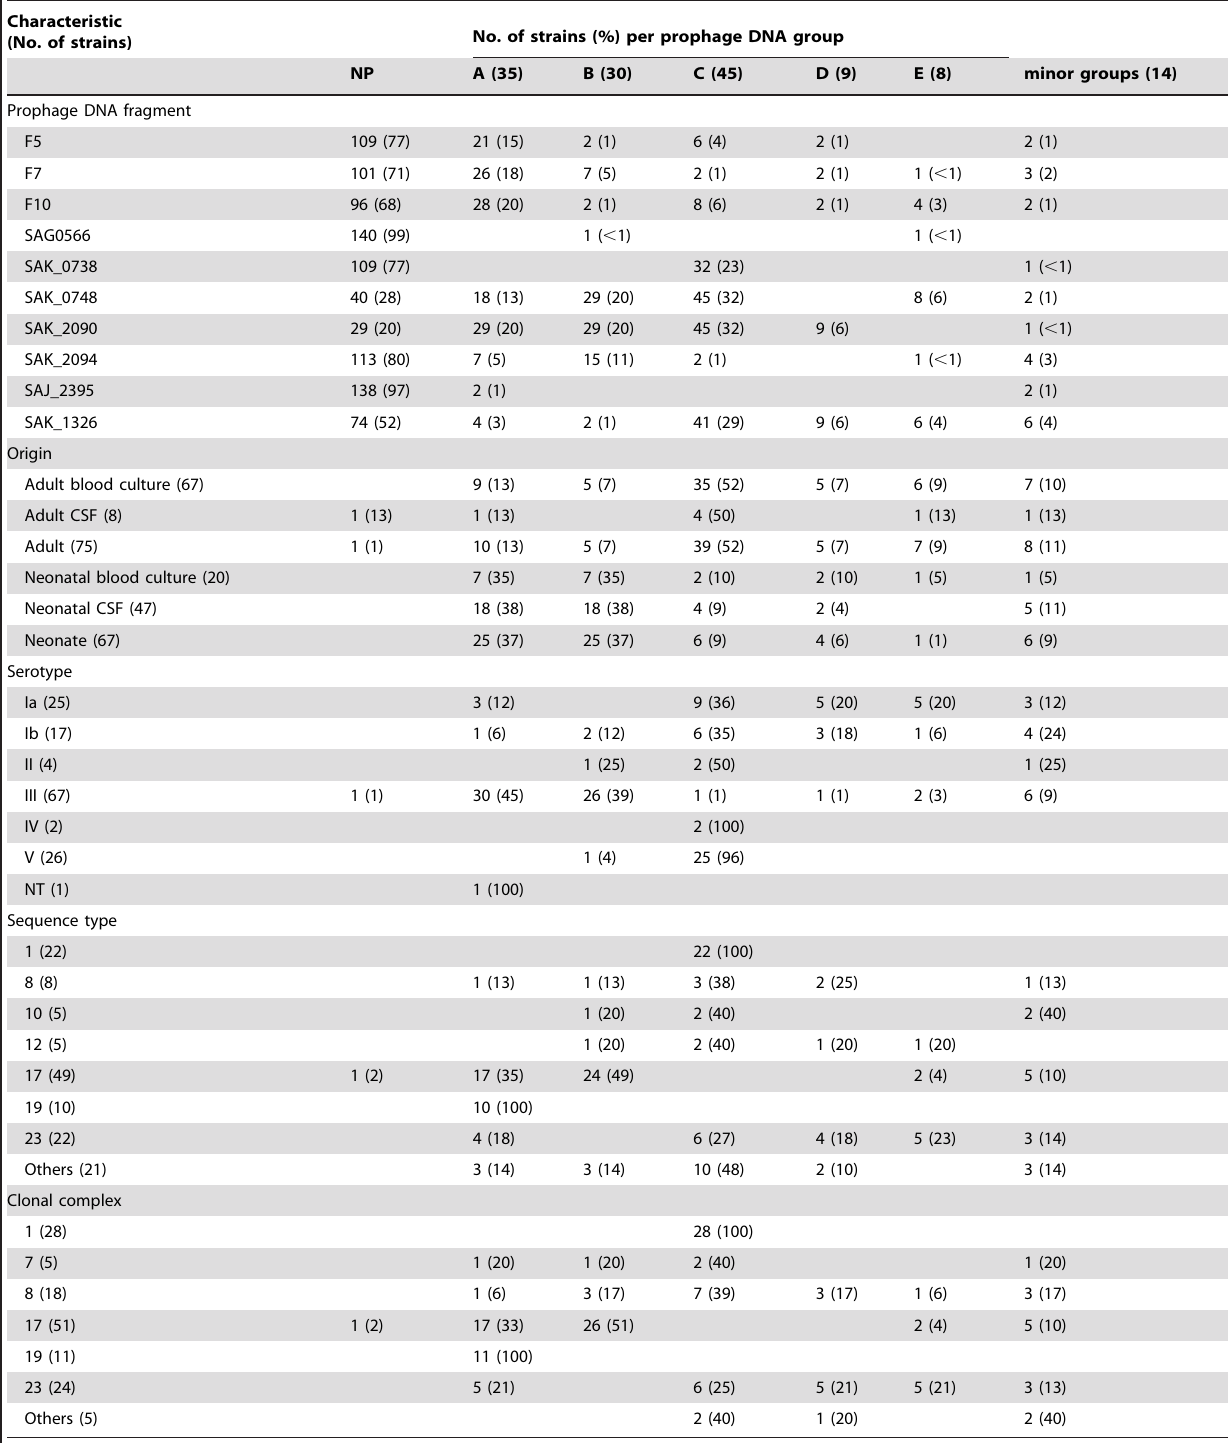
Table 6. Distribution of the S. agalactiae isolates of various origins, serotypes, sequence types, and clonal complexes between prophage DNA groups, as displayed by SYSTAT 12 software a